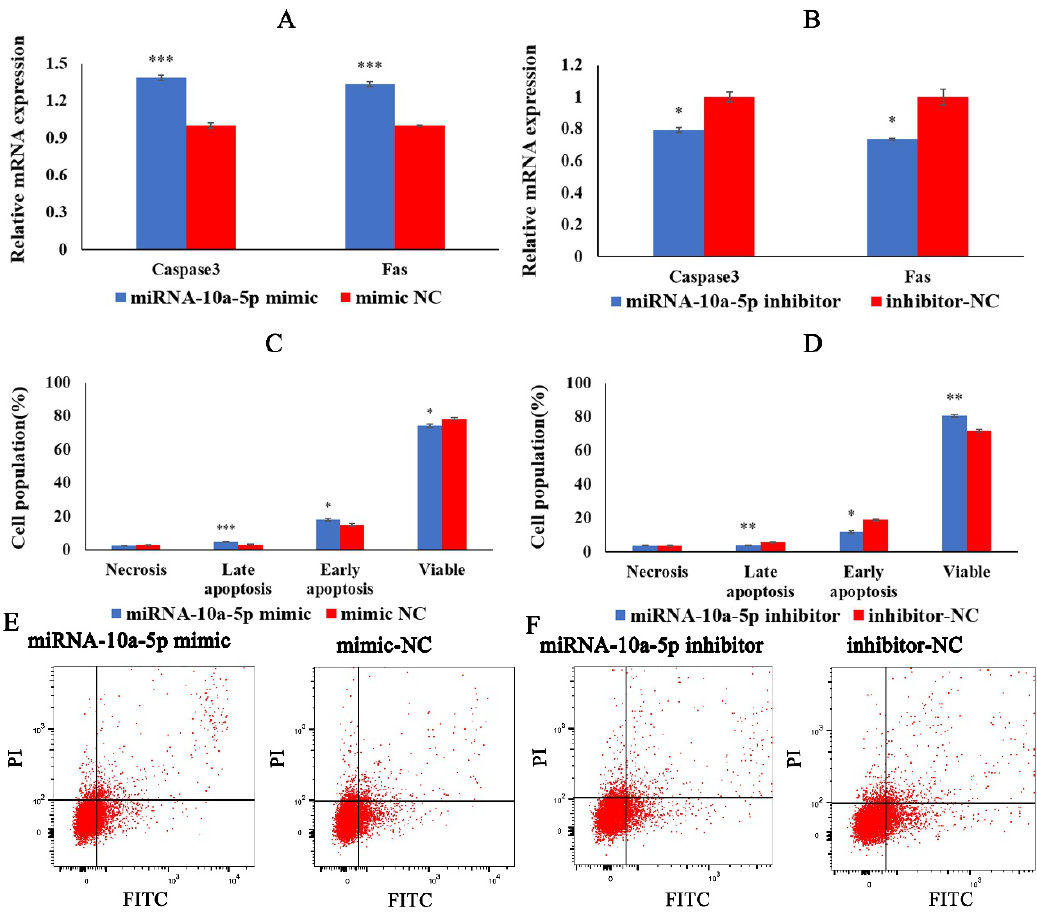
Figure 3. miRNA-10a-5p promotes chicken myoblasts’ apoptosis. ( A , B ) The relative expression of apoptosis marker genes Caspase3 and Fas by qRT-PCR after transfection with miRNA-10a-5p mimic and inhibitor. ( C , D ) Statistical chart of FCM test results. ( E , F ) The scatter plot of the FCM results after transfection with miRNA-10a-5p mimic and inhibitor. In all graphs, the results are shown as mean ± SEM (standard error of the mean) ( n = 3). * p < 0.05, ** p < 0.01, *** p <0.001.